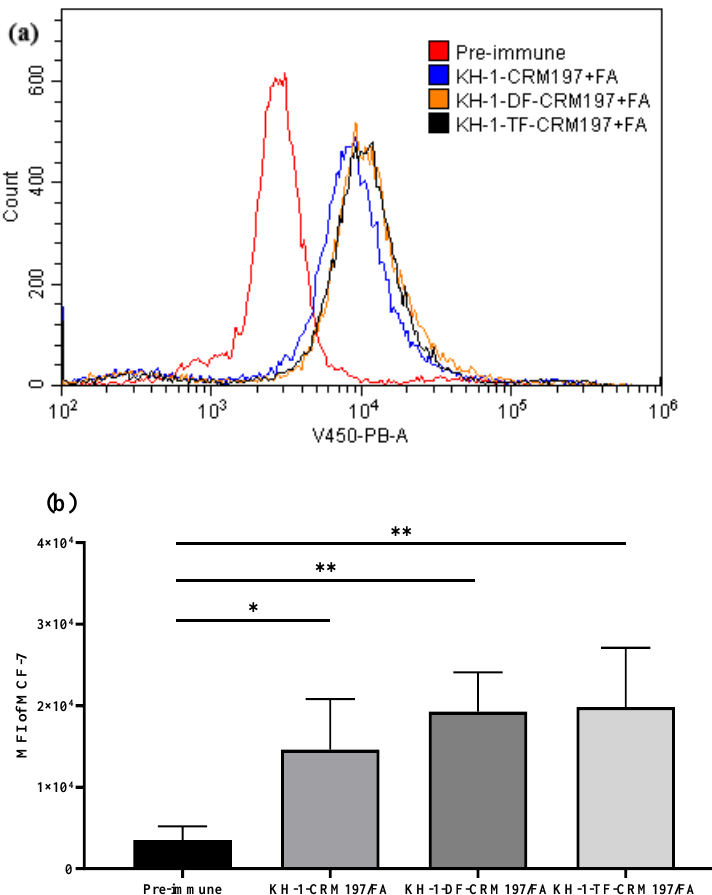
Figure 4. Recognition of human tumor cells by IgG antibodies in antisera: ( a ) serological IgG analysis results on MCF-7 human breast cancer cells after the fourth immunization via flow cytometry; ( b ) mean fluorescence intensity (MFI) of the IgG antibody’s binding to MCF-7 cells. Results are representative of three independent experiments. One-way ANOVA analysis was performed. * p < 0.05, ** p < 0.01.